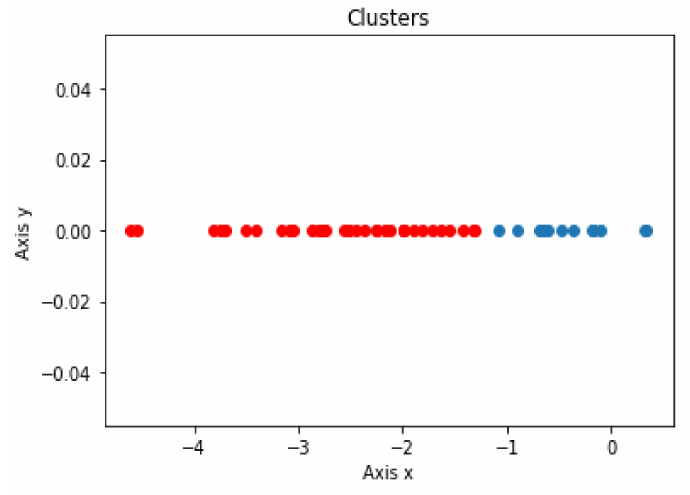
Figure 7. Distribution of predicted Hierarchical Clustering result using LD1 as